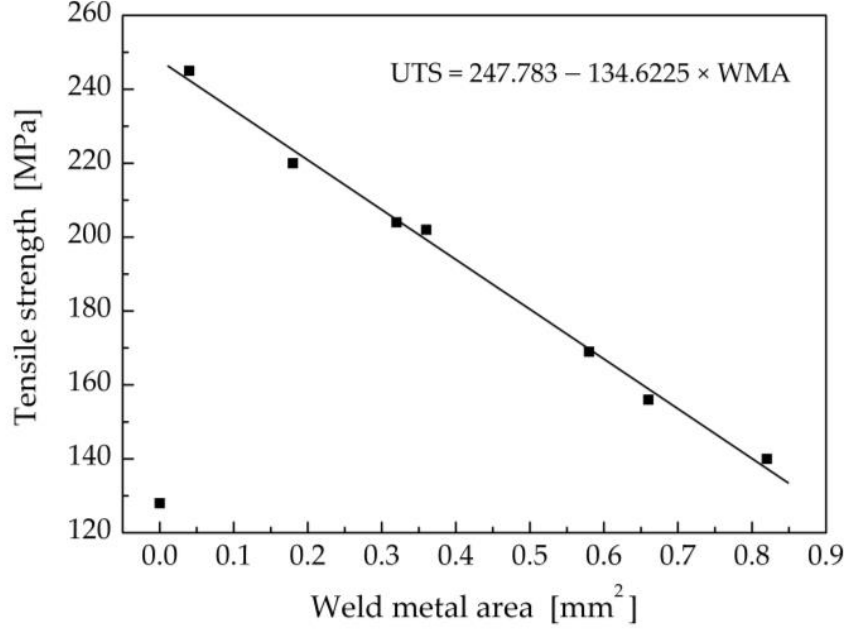
Figure 19. Dependence of the measured ultimate tensile strength of the weld joints on the computed Ti weld metal area.